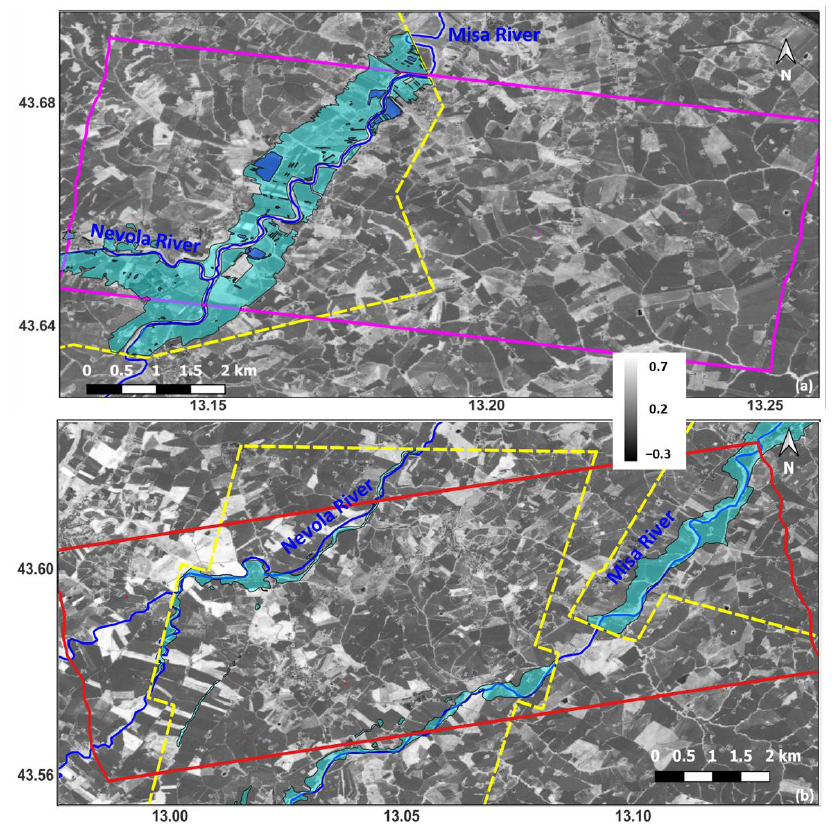
Figure 3. Flood trace (light blue) and flooded areas (darker blue) delineated by CEMS (activation code 634) superimposed on the NDVI maps produced using the S-2 image of the area hit by the Marche flood acquired on 12 September 2022 (orbit 122, tile T33TUJ). The maps also show the Misa River and the Nevola River. The Brugnetto and Ostra Vetere areas are highlighted in magenta ( a ) and red ( b ), respectively. The areas of interest included in the CEMS products are highlighted by the dashed yellow lines.